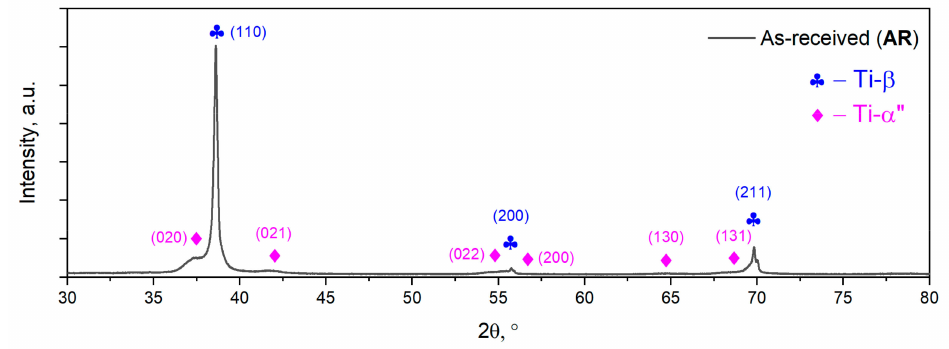
Figure 4. XRD spectra of the AR TNZT alloy. The Ti- β phase was indexed in the body-centered cubic (BCC) system, belonging to the 229/I m − 3 m space group, with a lattice parameter close to a β = 0.329 nm, while the Ti- α (cid:48)(cid:48) martensite phase was indexed in the orthorhombic (O) system, belonging to the 63/C m c m space group, with the lattice parameters a α (cid:48)(cid:48) = 0.298 nm, b α (cid:48)(cid:48) = 0.492 nm and c α (cid:48)(cid:48) = 0.463